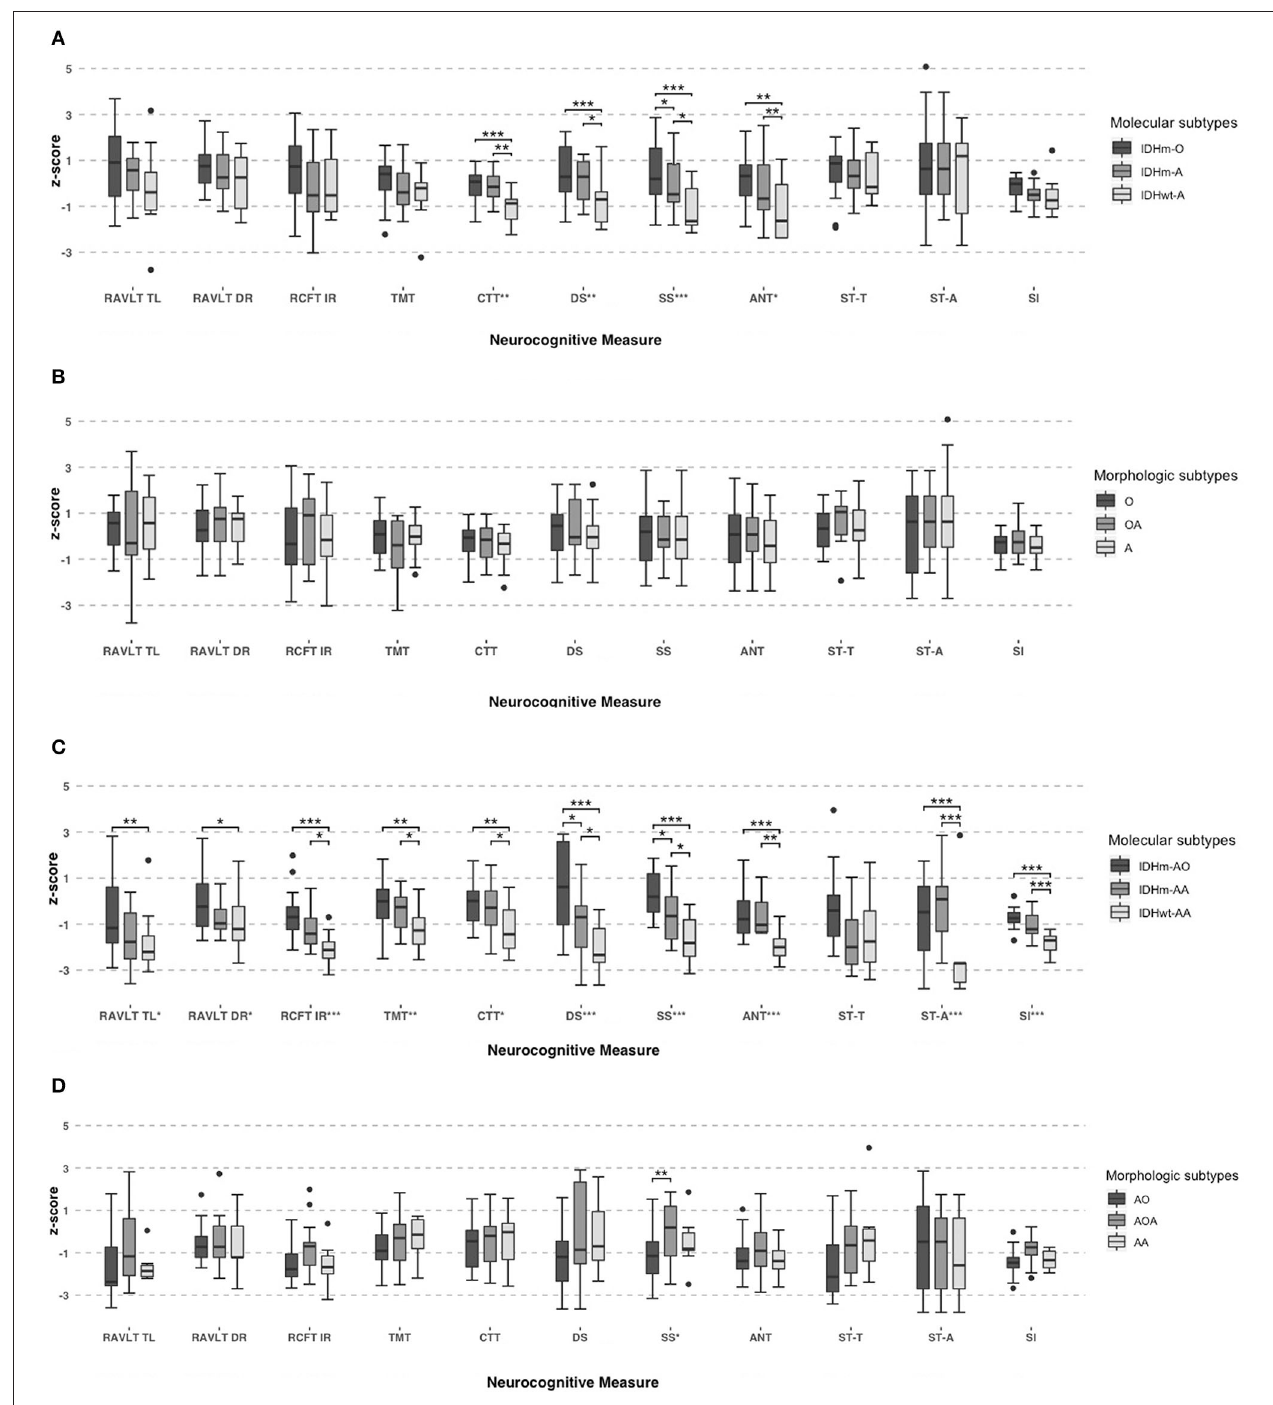
FIGURE 2 | Neurocognitive performances in grade II subgroups based on molecular (IDH1 and 1p19q status) (A) and morphologic criteria (B) . And neurocognitive performances in grade III subgroups based on molecular (IDH1 and 1p19q status) (C) and morphologic criteria (D) . One-Way ANOVA tests and pairwise comparison used for group comparisons. *Significant, P < 0.05; **Significant, P < 0.01; ***Significant, P <